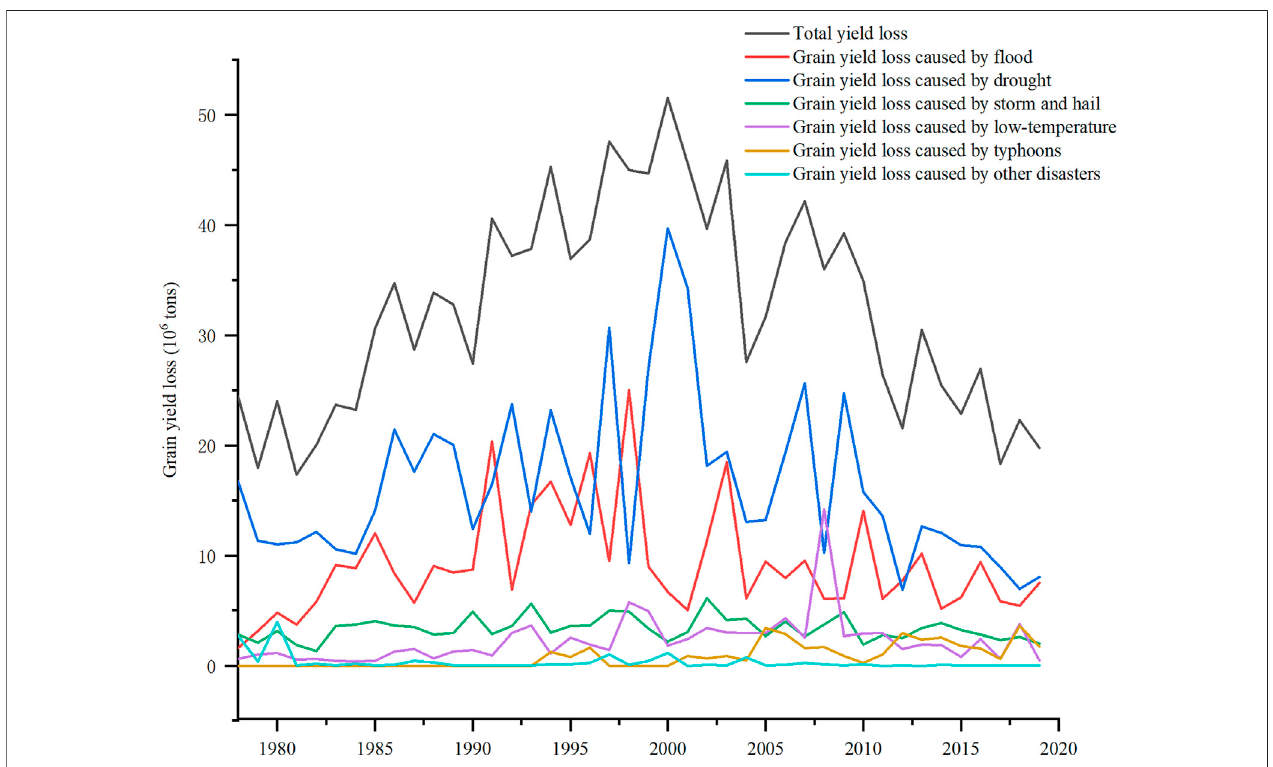
FIGURE 1 | China ’ s disaster-induced grain yield loss from 1978 to